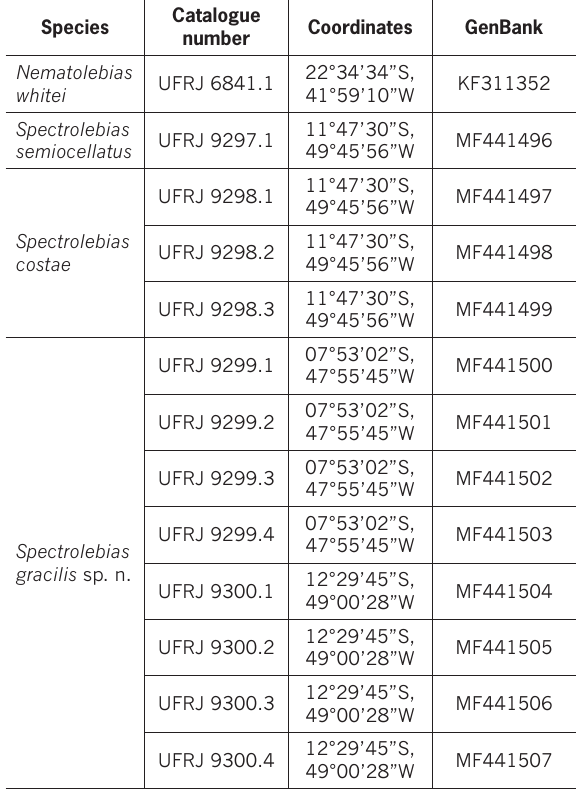
Table 1. List of specimens used in molecular analysis, with re